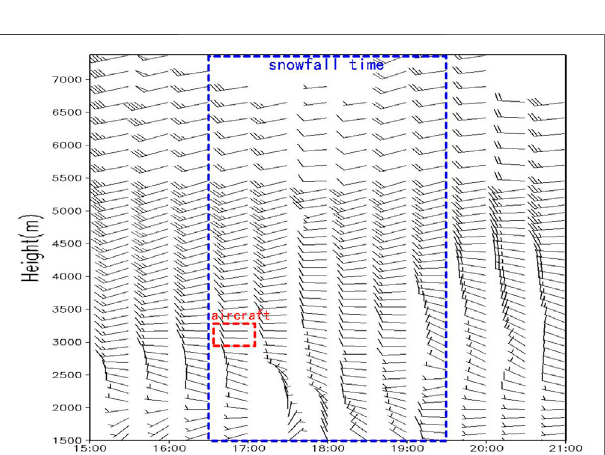
Figure 7A , the snowfall at Yanjiaping station started at 16:30, the cloud top gradually rose up (from 2.5 to 4 km), and the strong re fl ectivity factor (close to 15 dBZ) appeared in the altitude < 2 km.